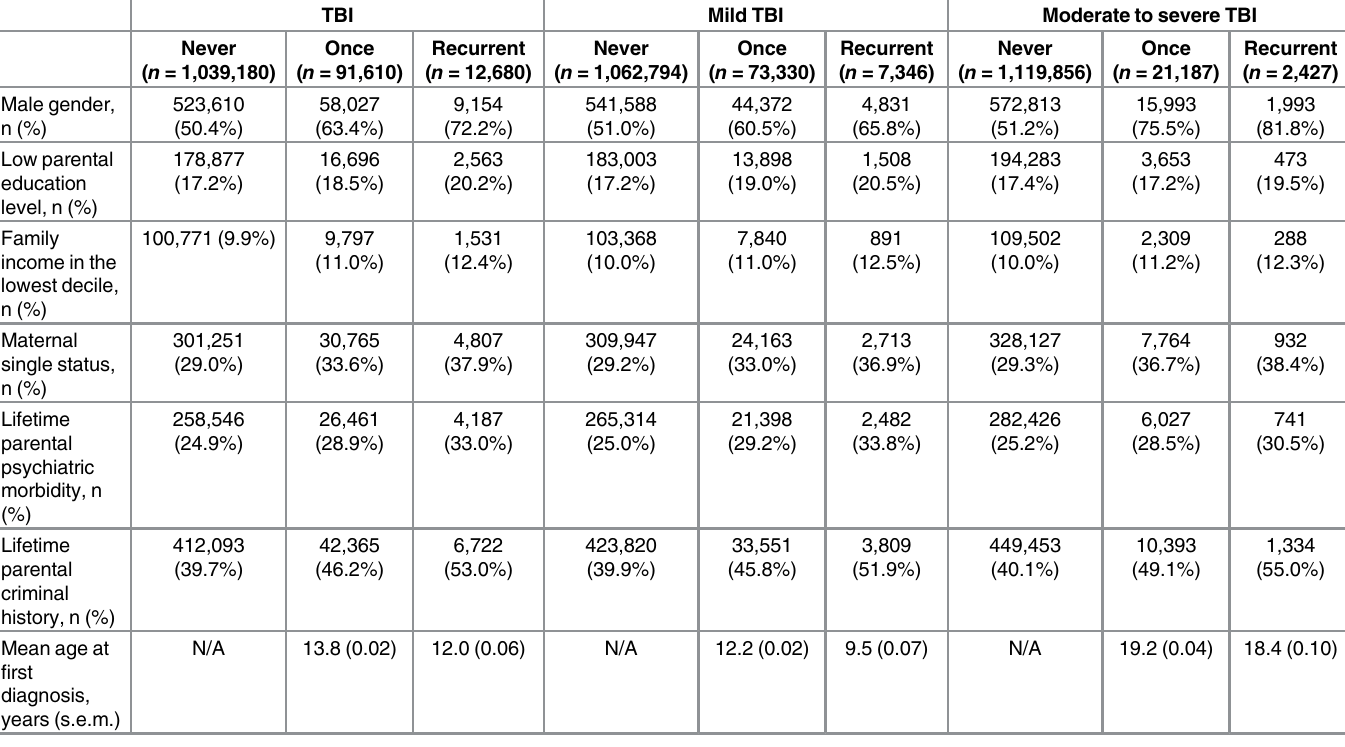
Table 1. Sociodemographic characteristics for the sample ( n =